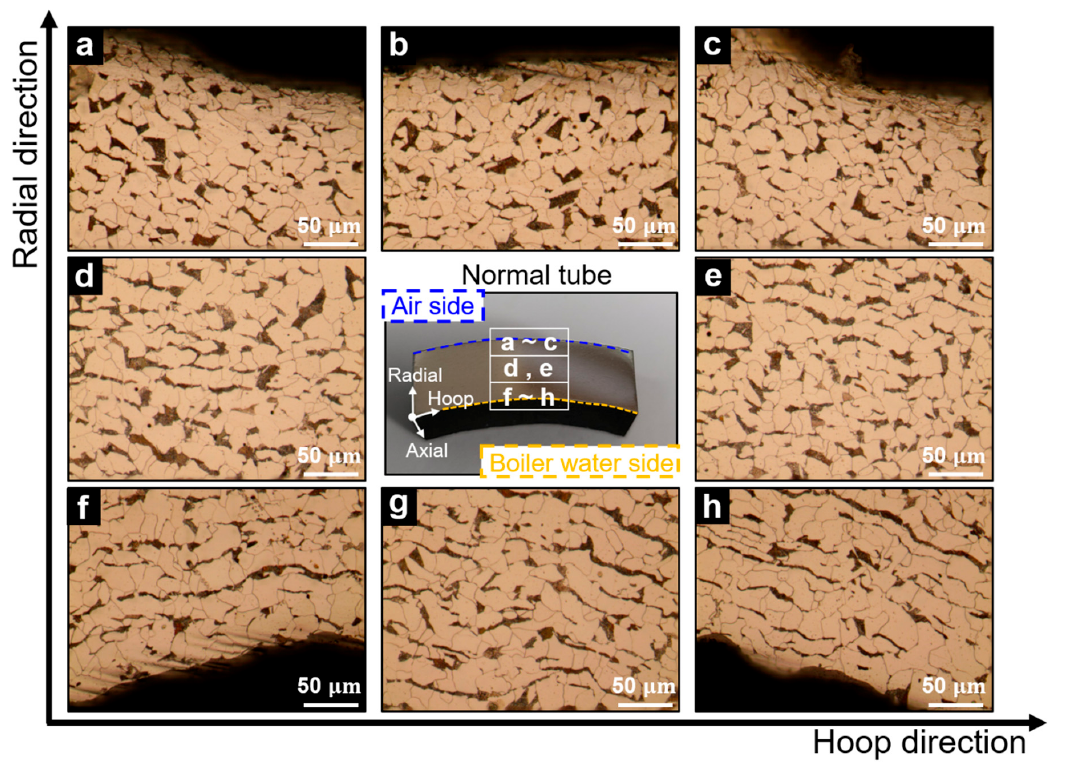
Figure 3. Microstructure analysis results of a normal (undamaged) tube: ( a – c ) images in the air side, ( d , e ) images at the mid-thickness, and ( f – h ) images in the boiler water-facing side.